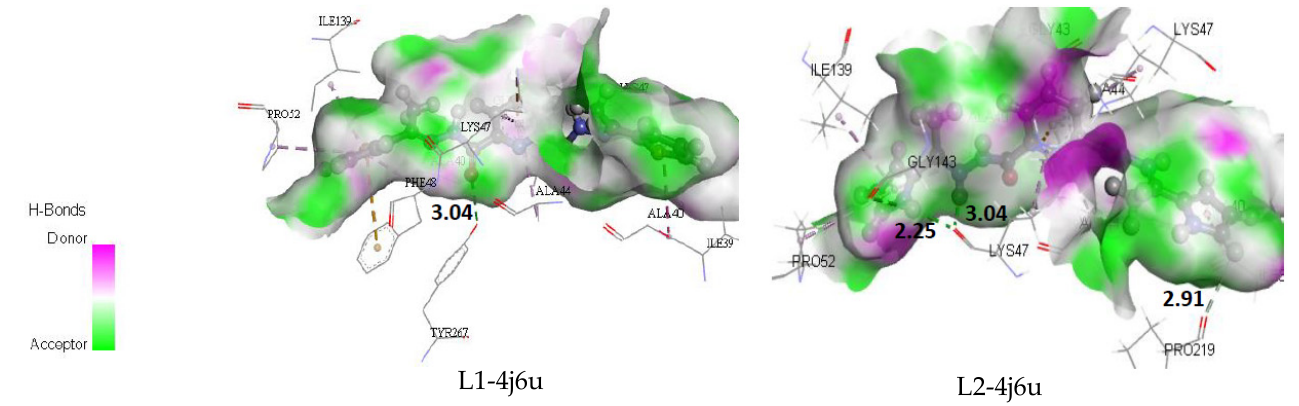
Figure 6. Picture showing interaction between ligands and amino acids of tyrosinase from Bacillus megaterium (PDB ID: 4j6u). The most important interaction distances (bold) are given in angstrom (Å).